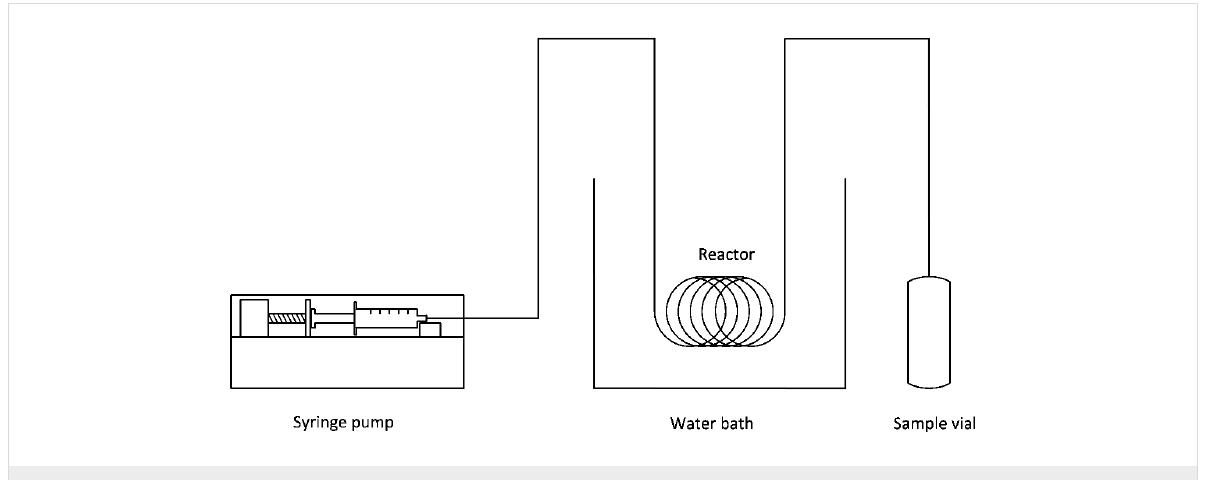
Figure 11: Flow reaction set-up using free